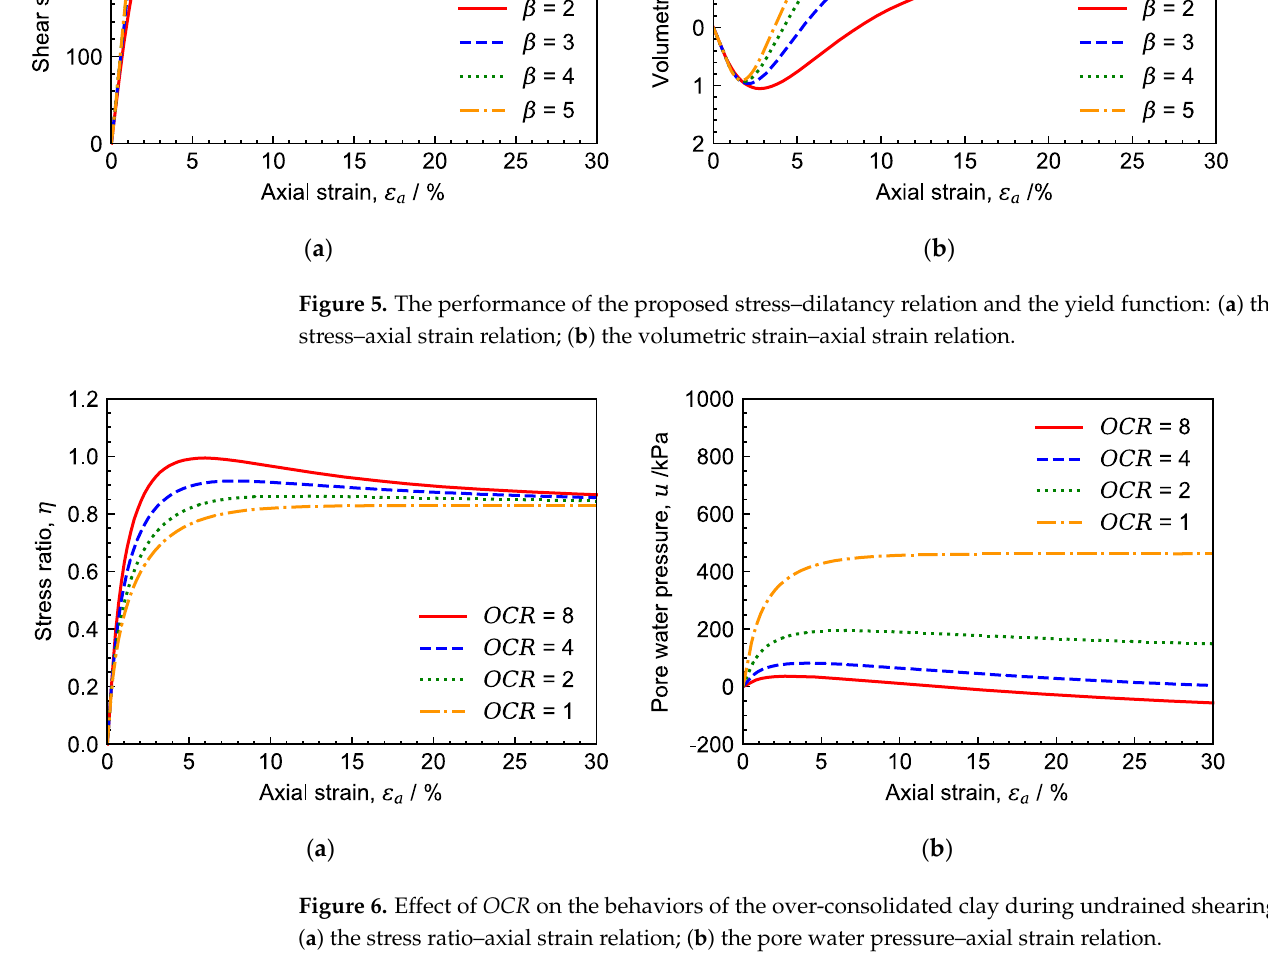
Figure 5. The performance of the proposed stress–dilatancy relation and the yield function: ( a ) the stress–axial strain relation; ( b ) the volumetric strain–axial strain relation.